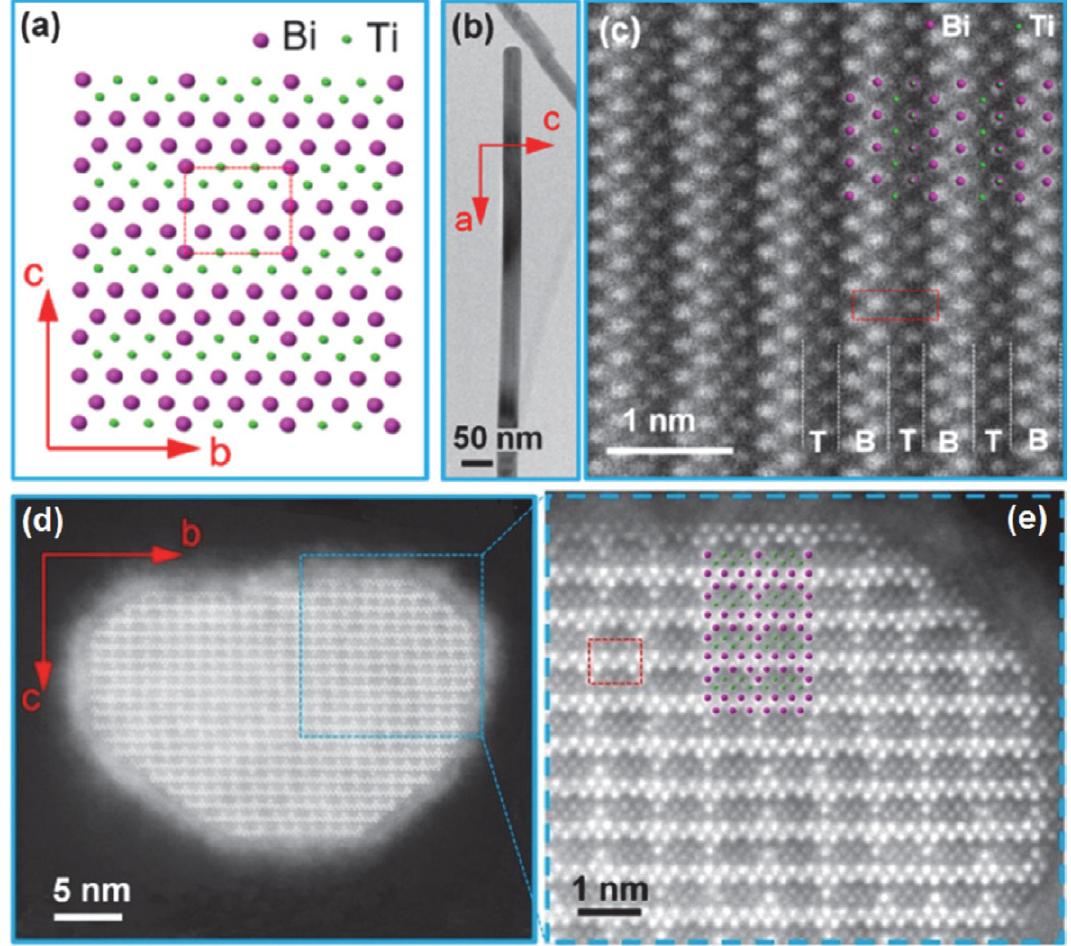
Figure 8. Cation arrangement in a tentative model of an orthorhombic structure of BIT NW (a), TEM (b) and HAADF STEM (c) images of NW orient- ed along the [010] direction, and HAADF STEM images ((d) and (e)) of NW oriented along the [100] direction of the orthorhombic structure. The projected model proposed for the NW structure is also superimposed over the images (c) and (e) to illustrate the positions of the Bi 3+ and Ti 4+ ions. The unit cell of the NW structure is marked with a red rectangle on the HAADF image. ( Adapted from the publication by D. Makovec, N. Križaj, A.